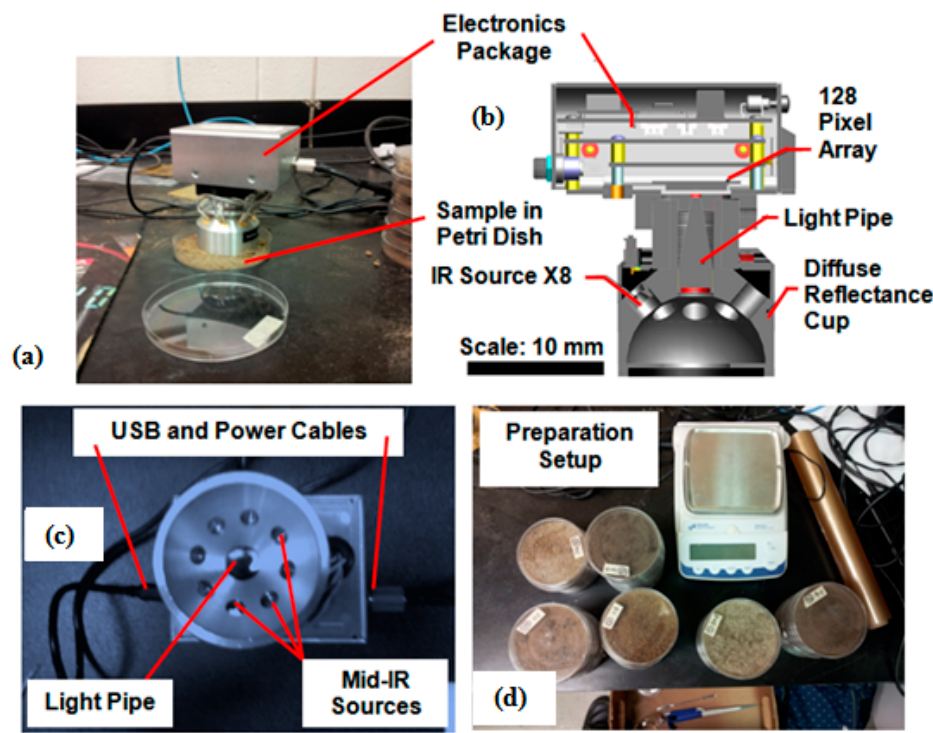
Figure 1. Illustration of the laboratory-configured portable mid-IR spectrophotometer (collecting measurements on soils in Petri dish ( a ), cross-sectional view ( b ), USB and power supply connections, light pipe, and sources of eight mid-IR ( c ), preparation setup ( d )).